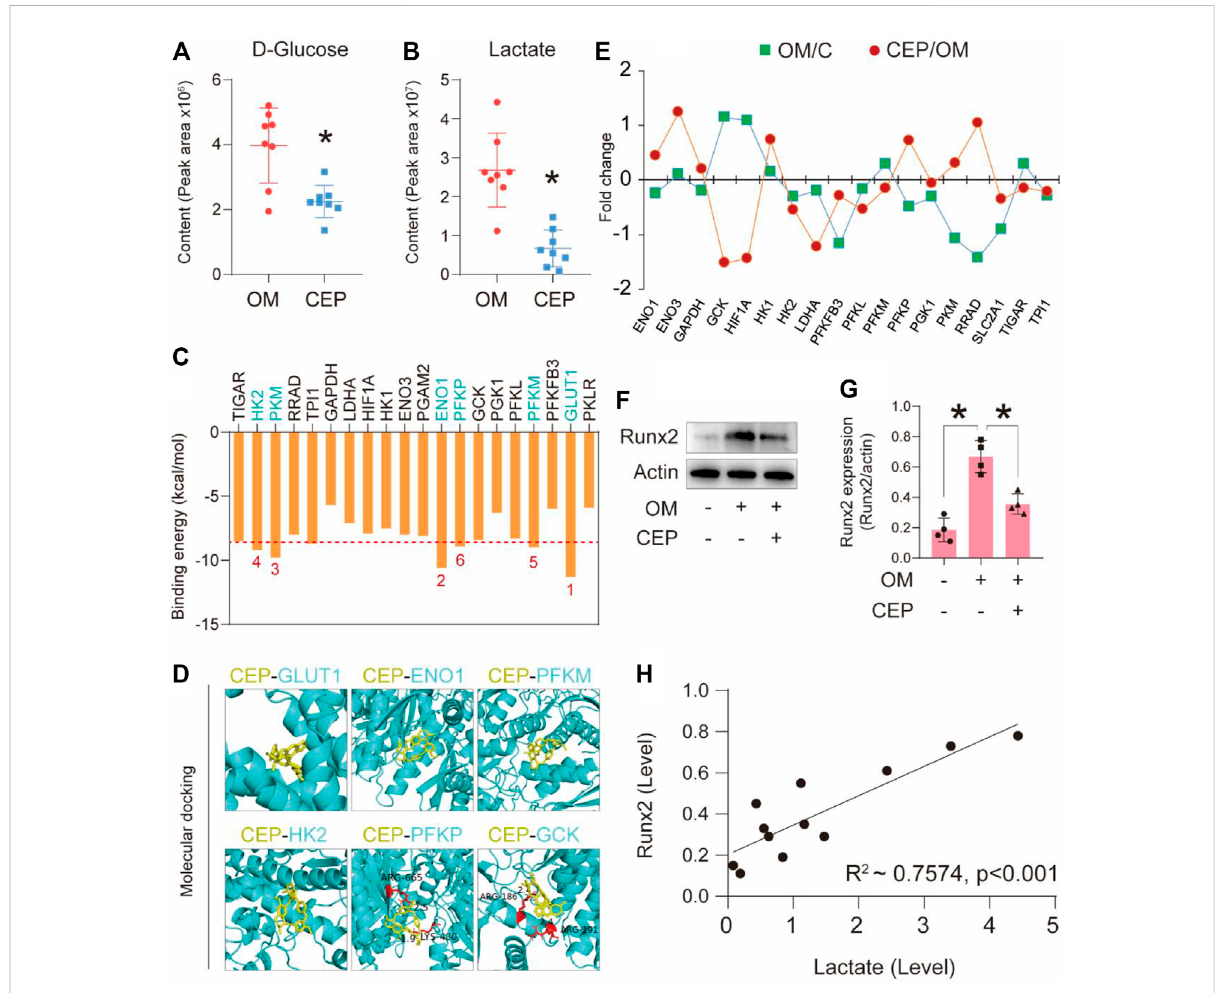
FIGURE 4 CEPinterfereswiththeglycolysispathwaytoconferanti-calci fi cationeffects. (A) and (B) TherelativecontentofD-glucoseandlactatebasedon the peak area in metabolomic analysis; (*) p < 0.05 indicates signi fi cant difference; (C) binding energy of each protein with CEP via molecular docking; (D) topsixbindingenergyproteinsandCEP dockingdetails; (E) associated geneexpression pro fi lesofVICstreatedwithOMplusCEP inthe glycolysis pathway; (F) and (G) Runx2 expression in VICs with CEP treatment under the condition of OM induction; (*) p < 0.05 indicates signi fi cant difference; (H) correlation analysis based on lactate level and Runx2 expression